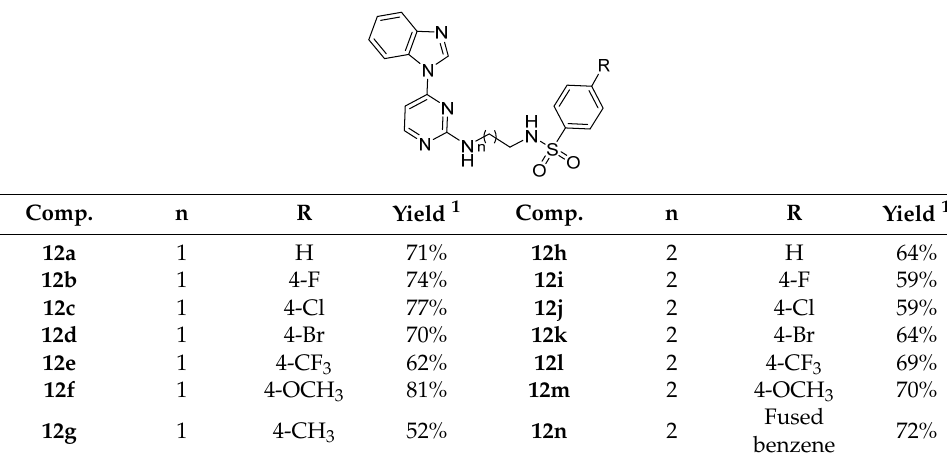
Scheme 3. Synthesis of the final compounds 12a–n . Table 1. General structure and yields of the final compounds 12a–n .